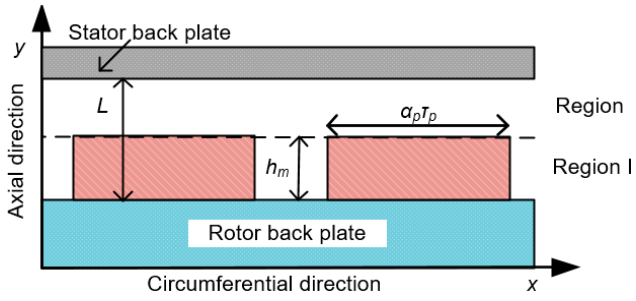
Figure 2. Representation of field regions divided by magnets.